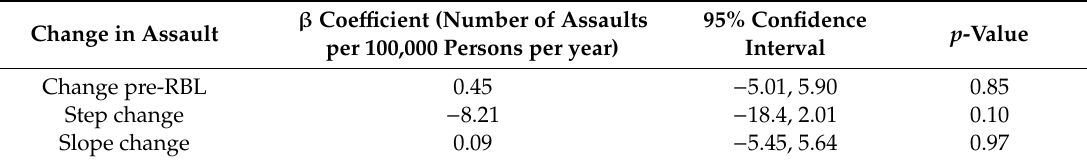
pre to post RBL in Queensland,